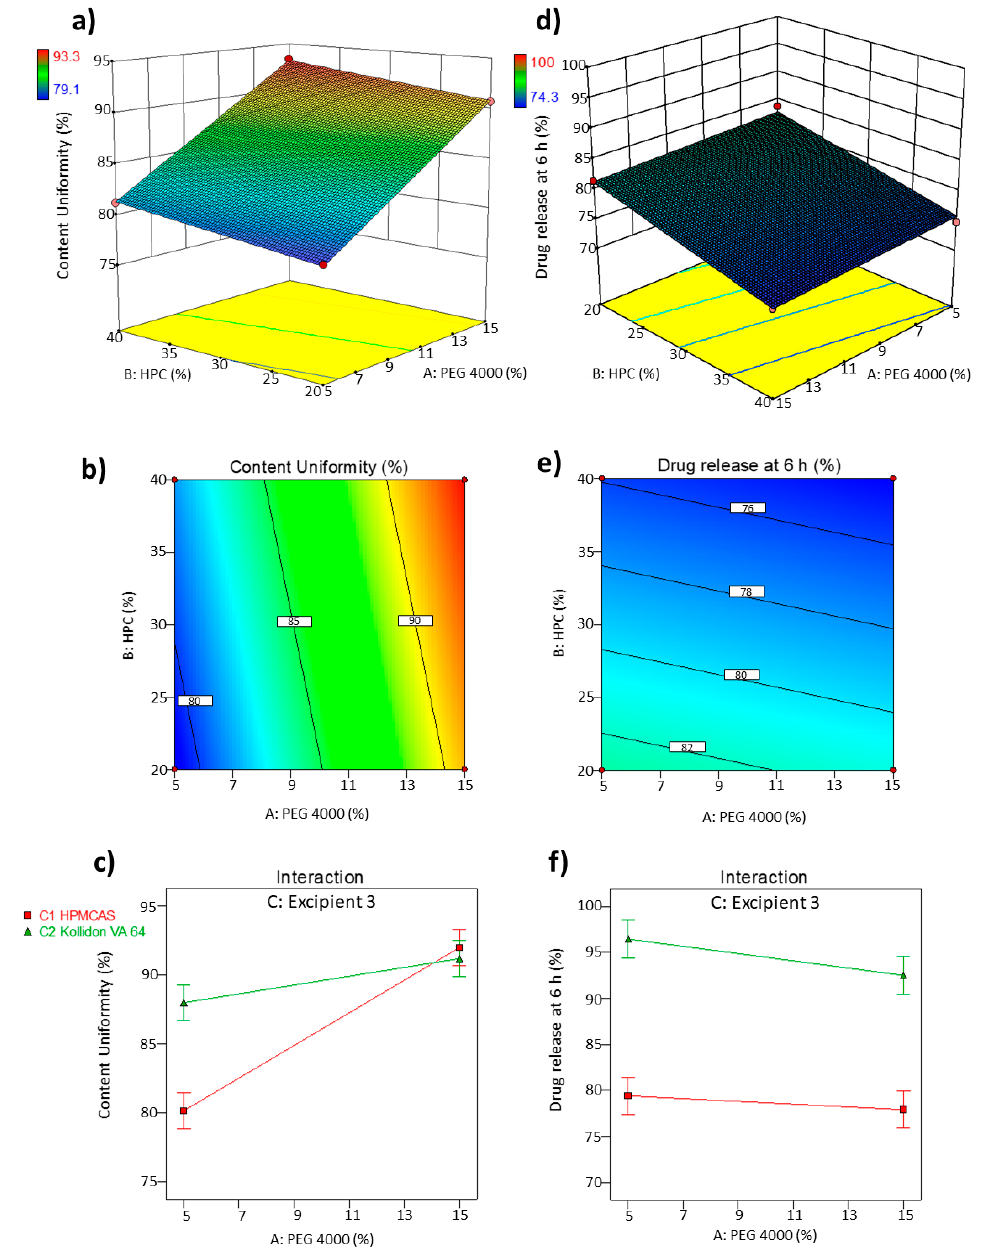
Figure 1. Optimisation of NFD 3D printed minitablets by direct powder extrusion. 3D response surface ( a , d ) and 2D contour plots ( b , e ) showing the influence of the amount of PEG 4000 and HPC on the content uniformity (%) and drug release at 6 h. Interaction between the excipients ( c , f ) HPMCAS and KVA 64 in content uniformity (%) and drug release at 6 h (%).